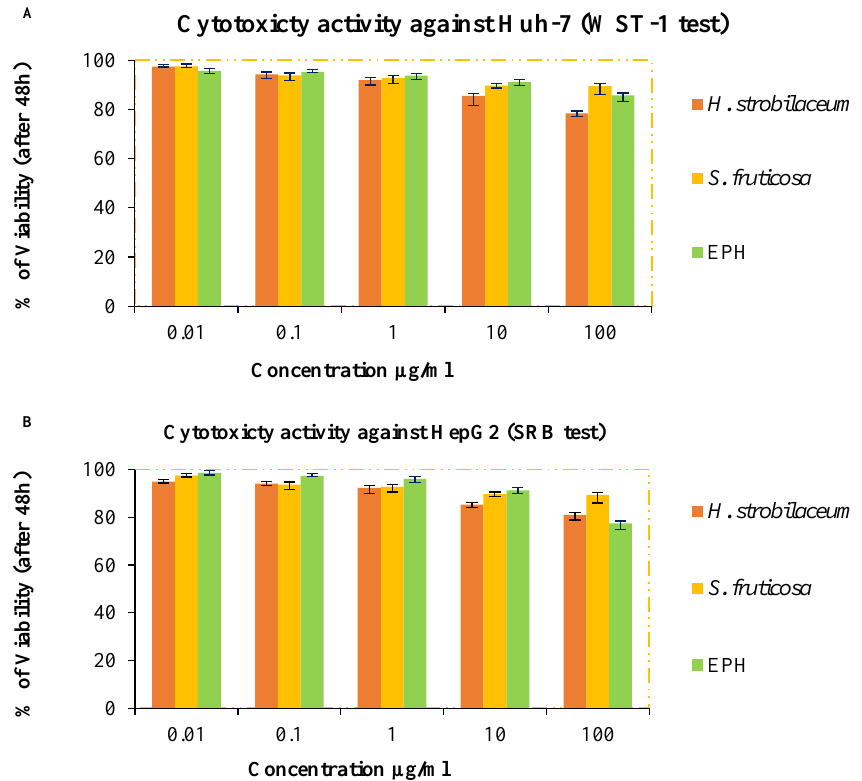
Figure 3. In vitro cytotoxicity assay for the hydro-methanolic extracts of H. strobilaceum , S. fruticosa and the positive control (EPH) against Huh-7 ( A ) and HepG2 ( B ) cells (0.01, 0,1, 1, 10, and 100 µg/mL).